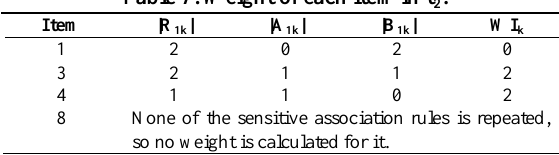
Table 8. Modified support and confidence after